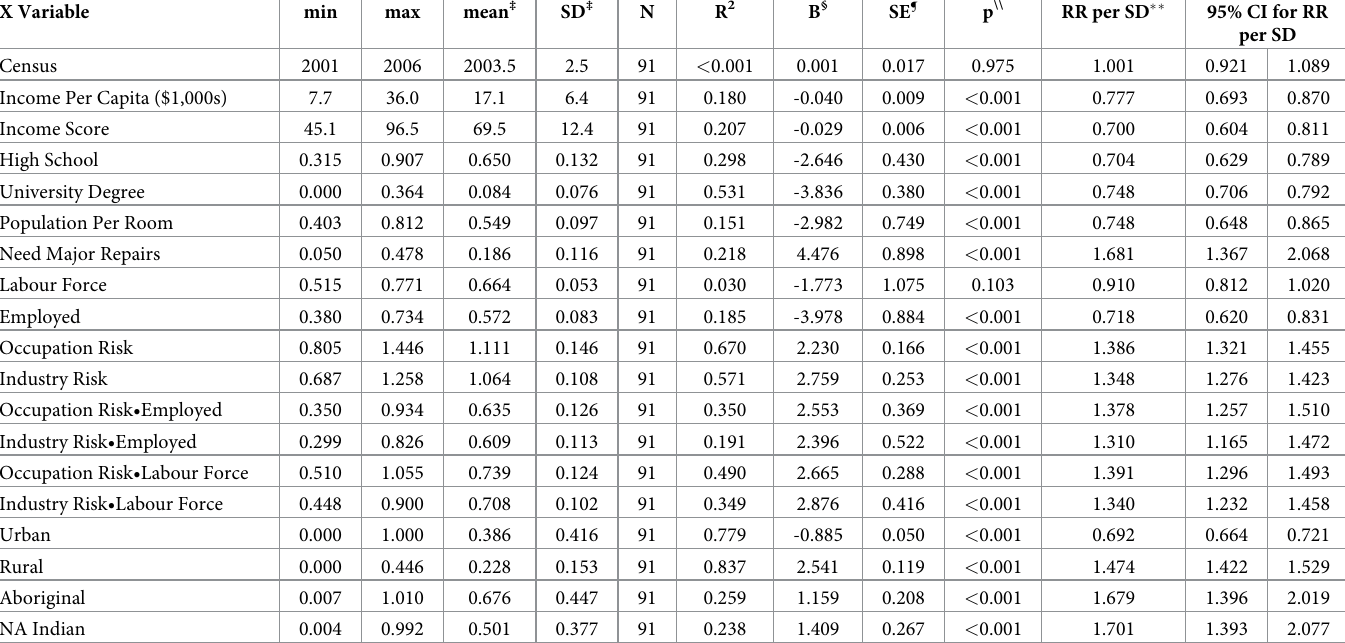
Table 6. Ecologic analysis (cid:3) of risk of hospitalization due to unintentional transport injury among Health Service Delivery Area Population Groups in British Columbia,